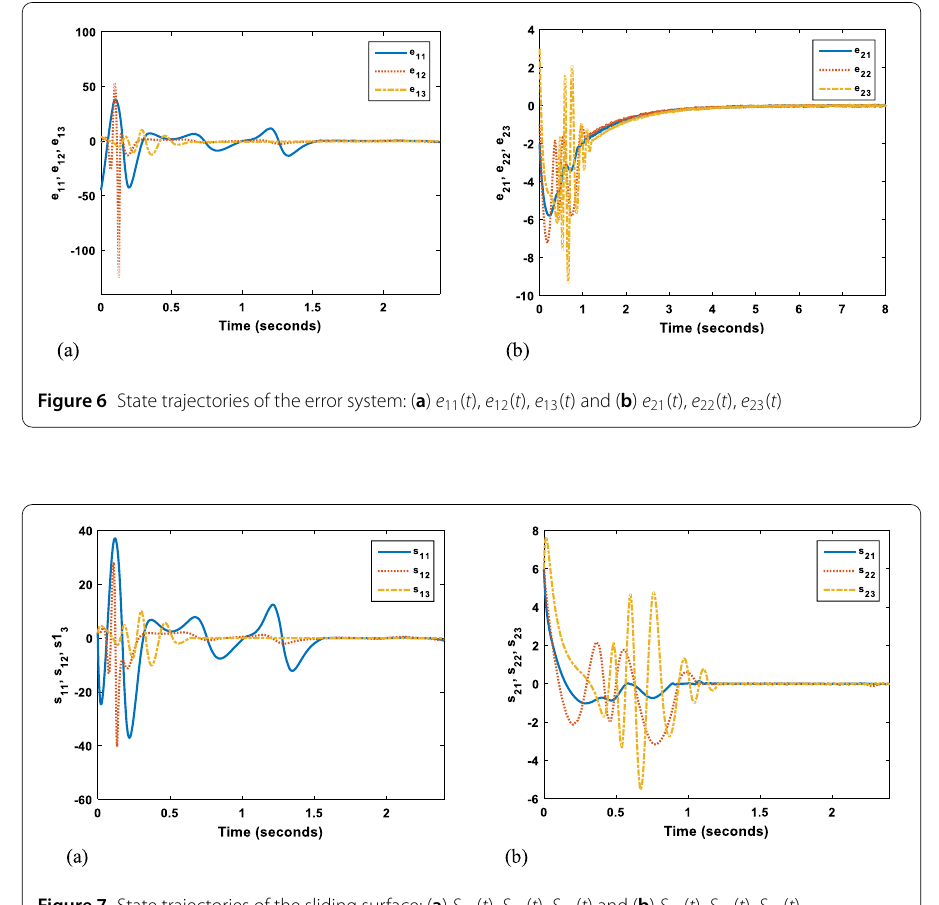
indicates that more slave systems and one master system are indeed synchronized. Fig- ure 7 shows the trajectories of sliding surface (13). Obviously, the control signal is practi-